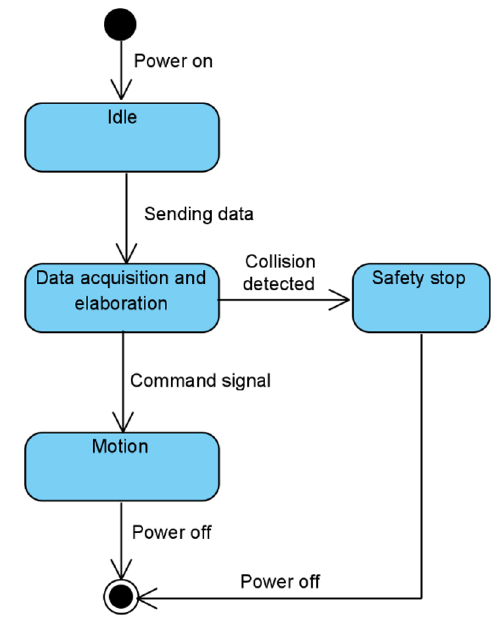
Figure 10. State machine diagram representing user operating